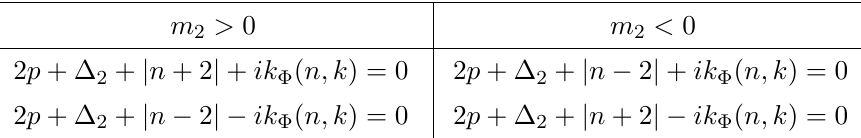
Table 2 . Conditions satis(cid:12)ed by Euclidean solutions with standard quasinormal boundary condi- tions. Each solution satis(cid:12)es one of the conditions listed. Here k (cid:8) ( n; k ) is given in equation (2.19). In this table, p runs over all non-negative integers, whereas n and k run over all integers. Euclidean modes that diverge at the tip of the Euclidean cigar, so they should be